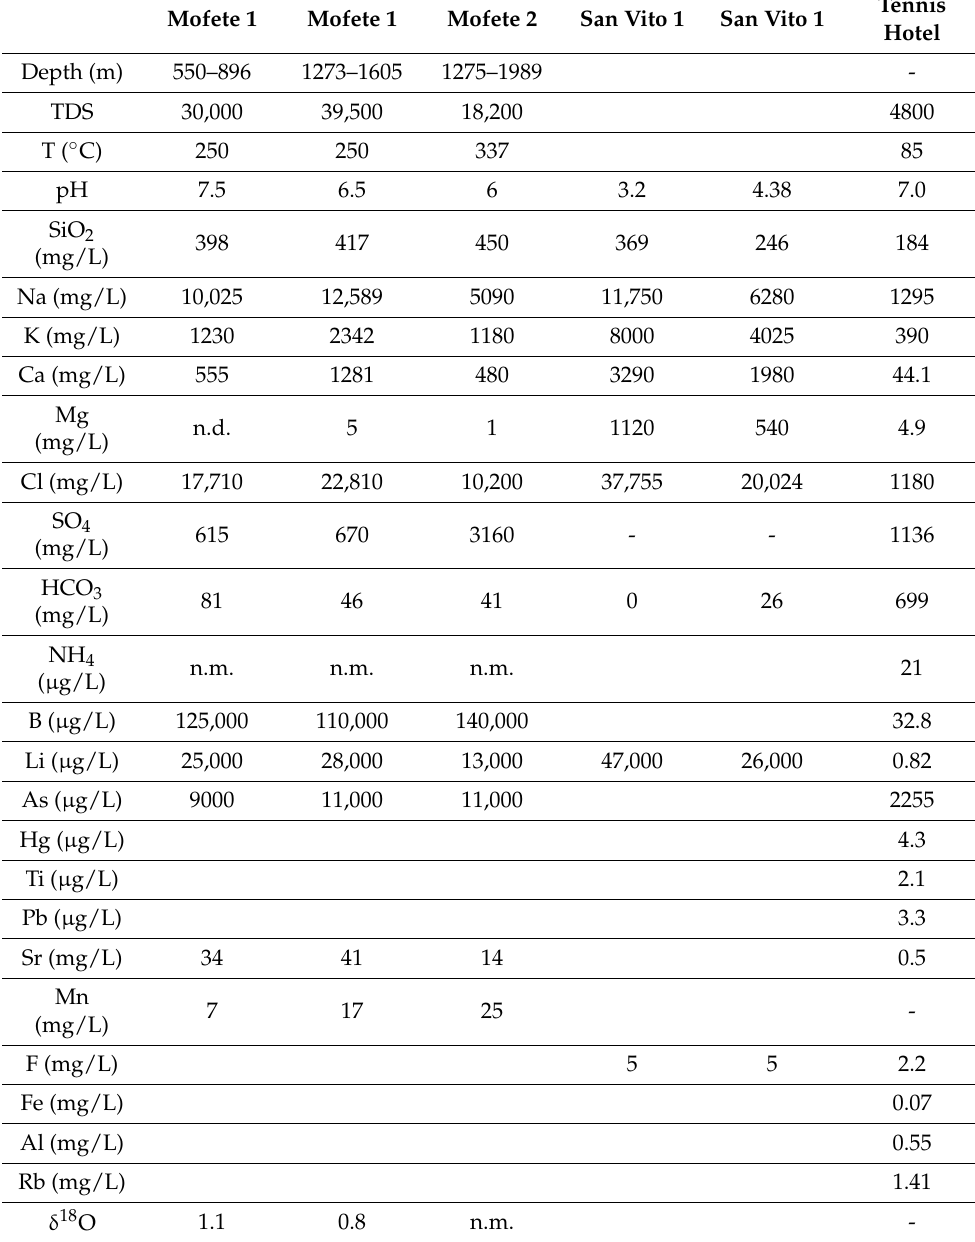
Table 3. Water chemistry at the Mofete wells, San Vito 1 well and Tennis